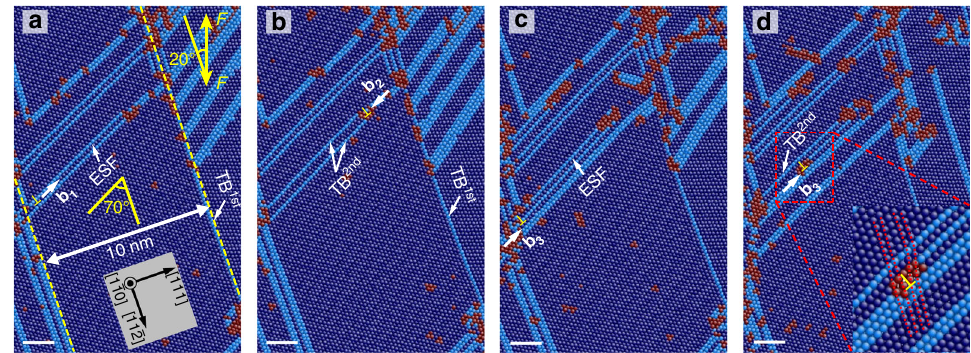
Fig. 5 Snapshots of secondary twinning in the fi rst NT. a Partial dislocation b1 is ready to propagate along extrinsic stacking fault (ESF). b The formation of TBs 2nd after propagation of b1 in a . c Detwinning back to ESF after propagation of b2 in b . d The second formation of TB 2nd owing to the propagation of b3 . The inset in d is an ampli fi ed con fi guration of partial dislocation during propagation. The λ of the fi rst NT is 10 nm. F is the uniaxial tensile load. Scale bars are